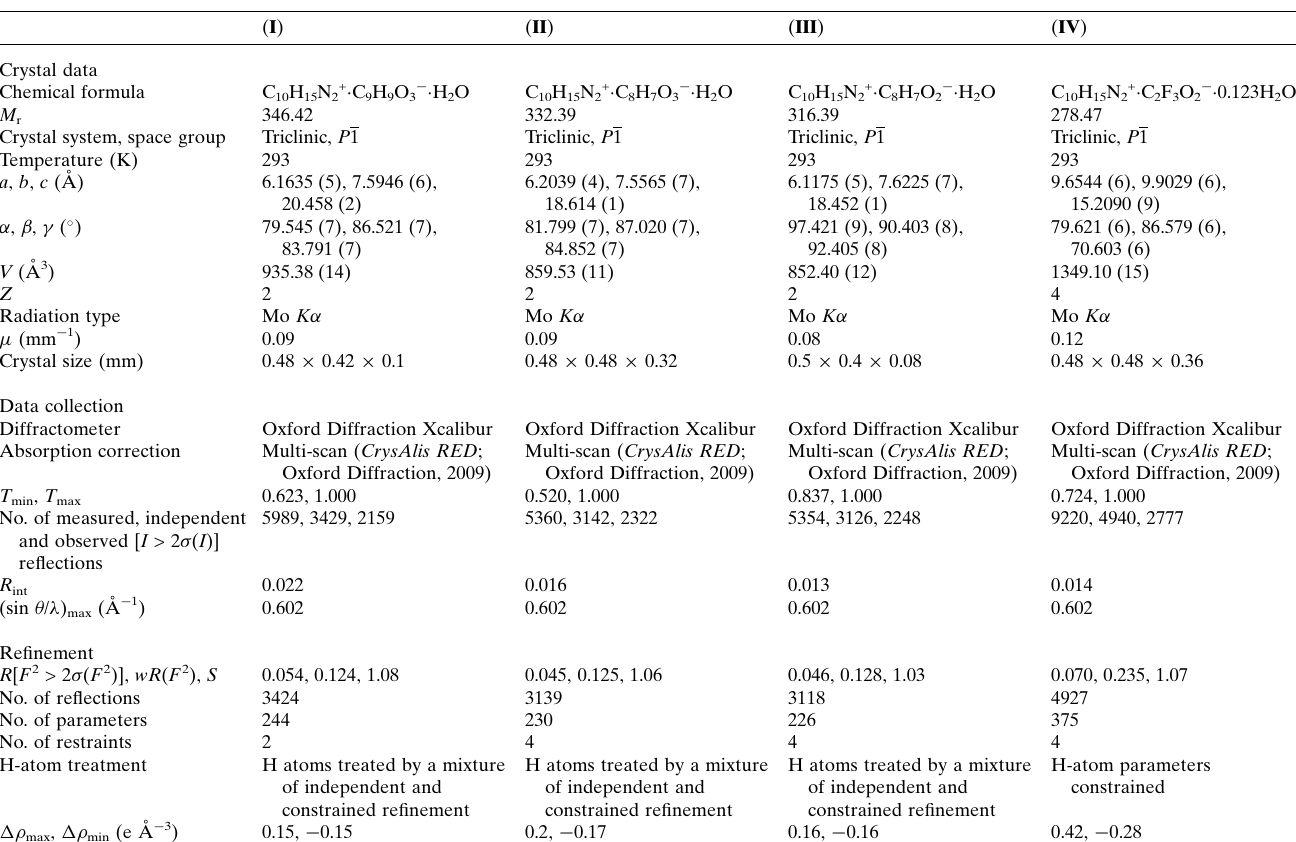
Table 5 Experimental details.